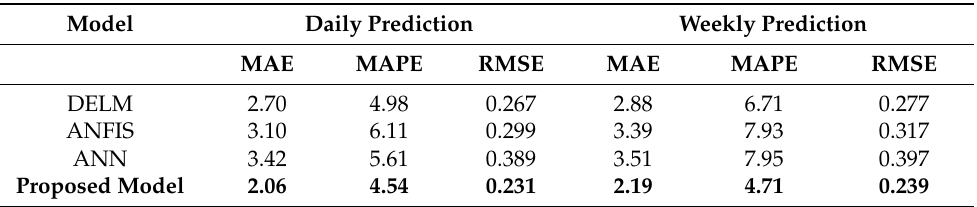
Table 4. Comparative analysis of proposed ensemble model with DELM, ANFIS, ANN, RNN on Daily and Weekly Floor level prediction. Model